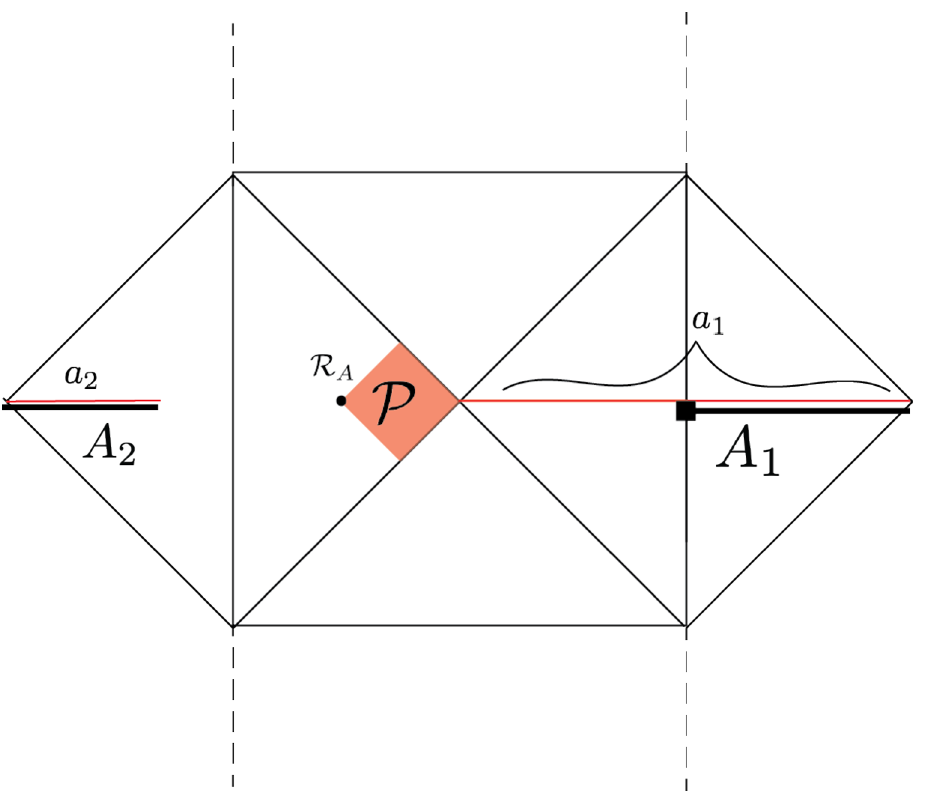
Figure 4 . We consider the region in the dual theory A = A 1 ∪ A 2 . In this figure, A 1 and A 2 are overlaid on the dual picture. The relevant regions in the gravity theory a